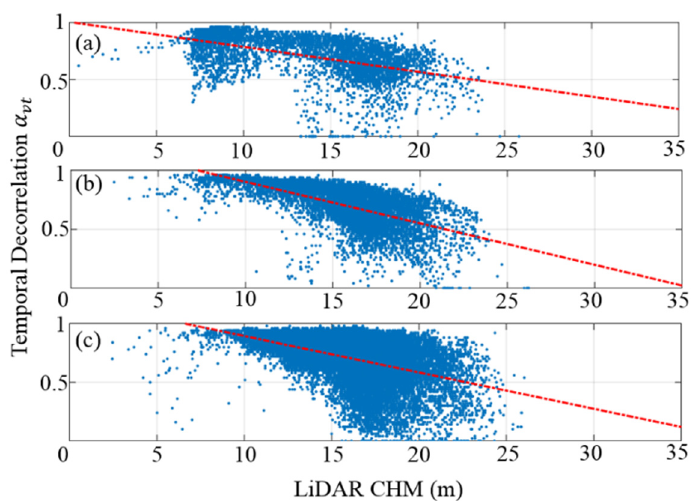
Figure 14. Linear fitting between the LiDAR-derived CHM and the temporal decorrelation factor limited by the different ranges of the D . I : ( a ) 0 < D . I ≤ 0.4; ( b ) 0.4 < D . I ≤ 0.65; and ( c ) D . I > 0.65 .